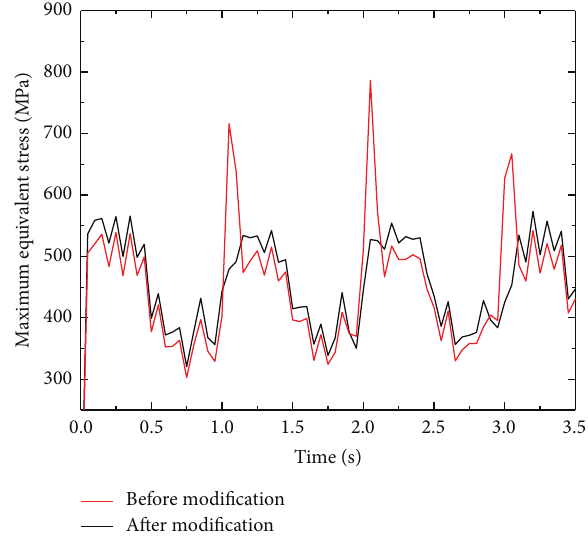
Figure 7: Transmission error curve of main gear before and after gear modification based on MASTA.